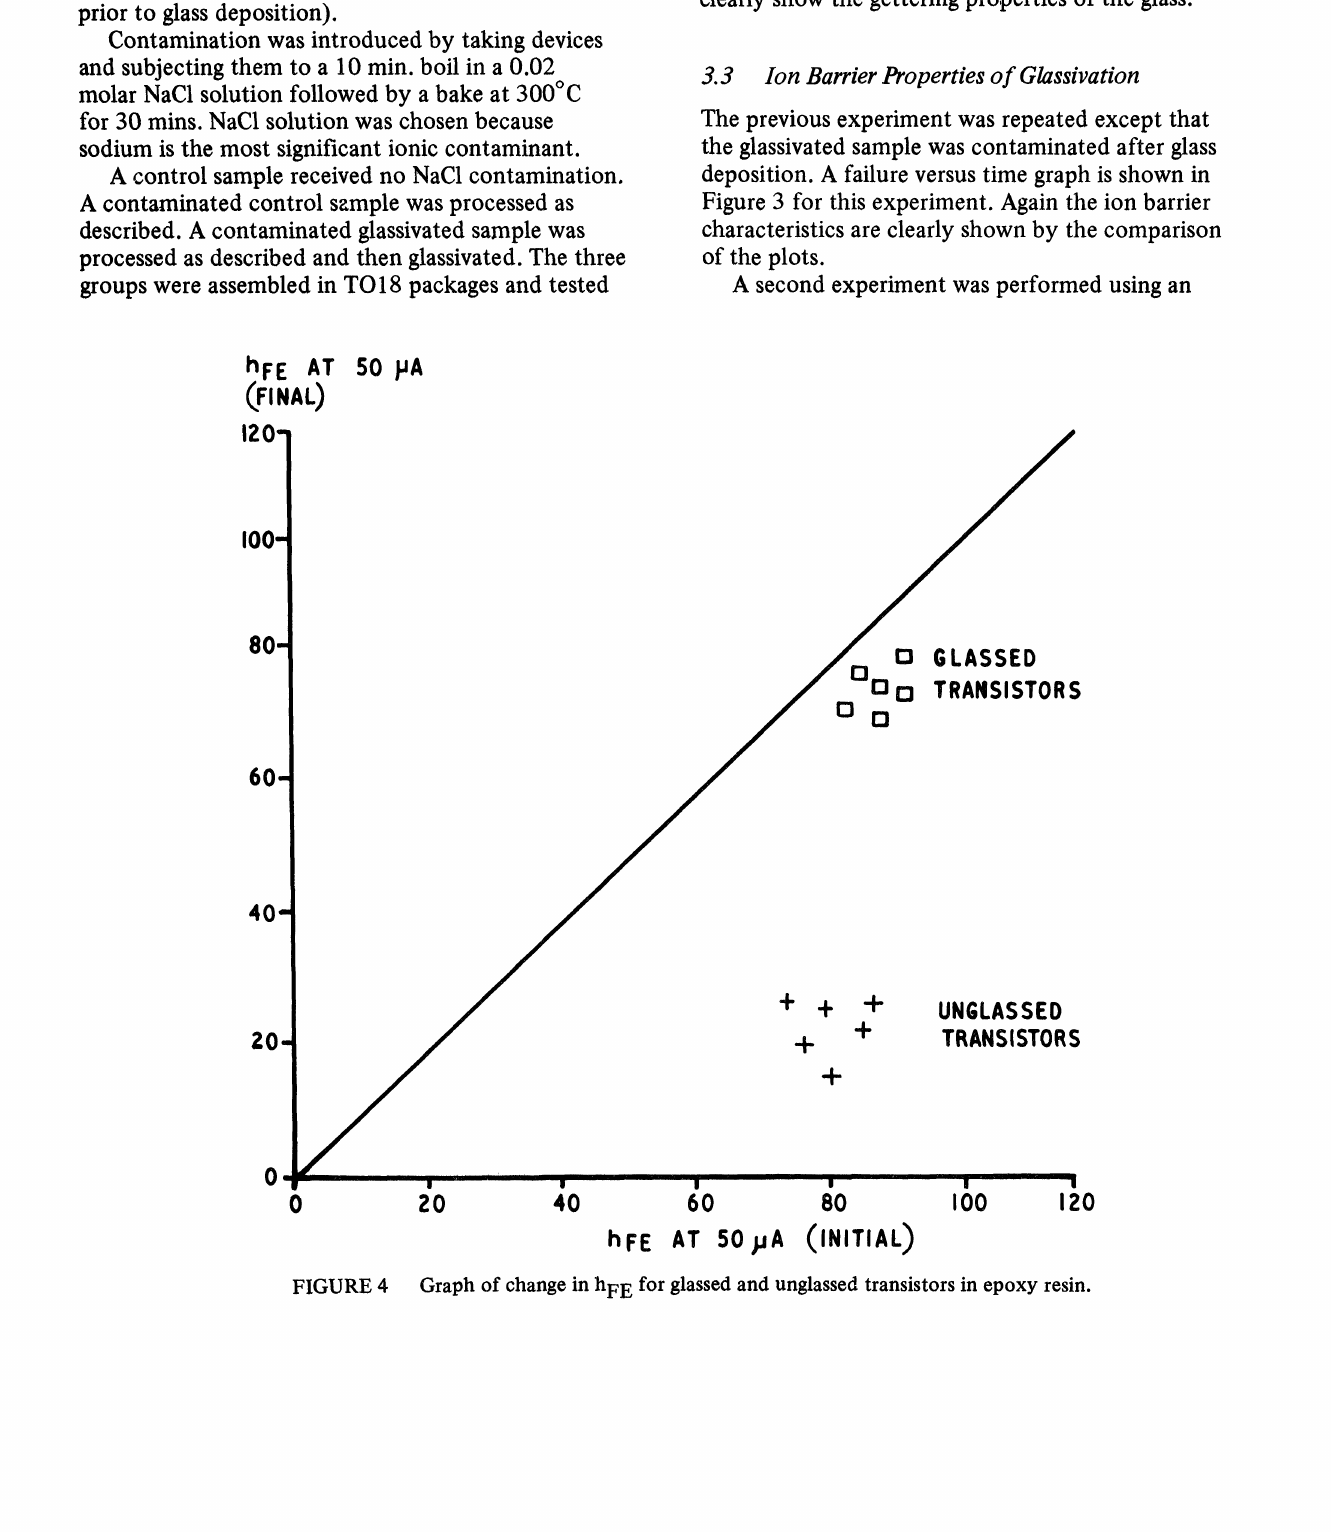
zo 40 eo ,oo hFE AT 50pA (INITIAL) FIGURE 4 Graph of change in hFE for glassed and unglassed transistors in epoxy